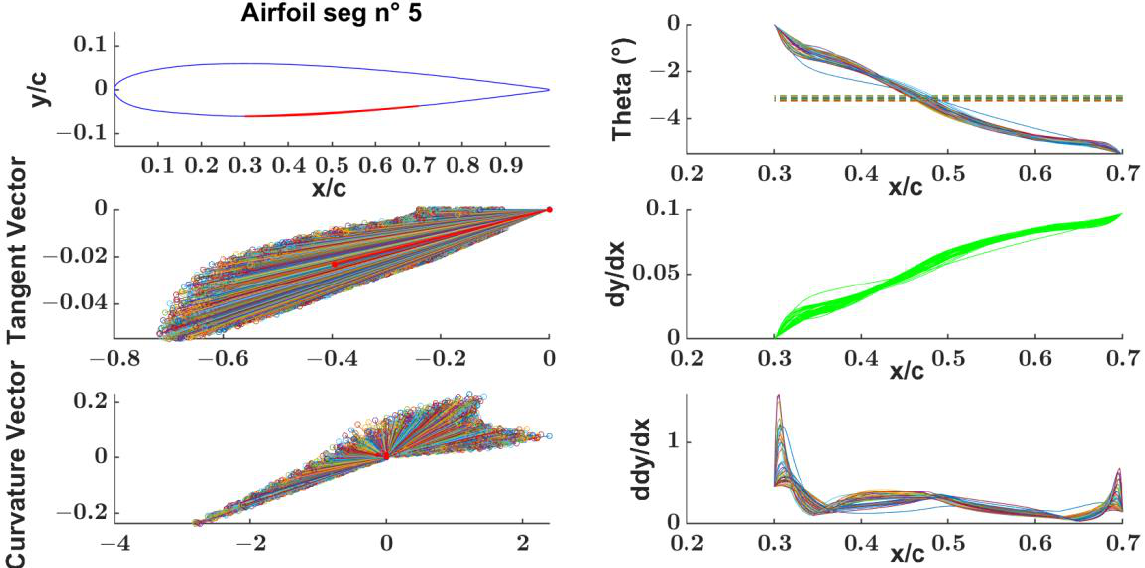
Figure 15. NACA 0012 step 2 segment 5 fitting process: theta (°), 1 st , 2 nd derivatives.